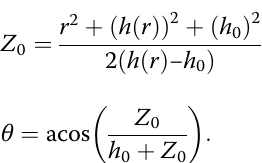
. The 0 , and the height at 0